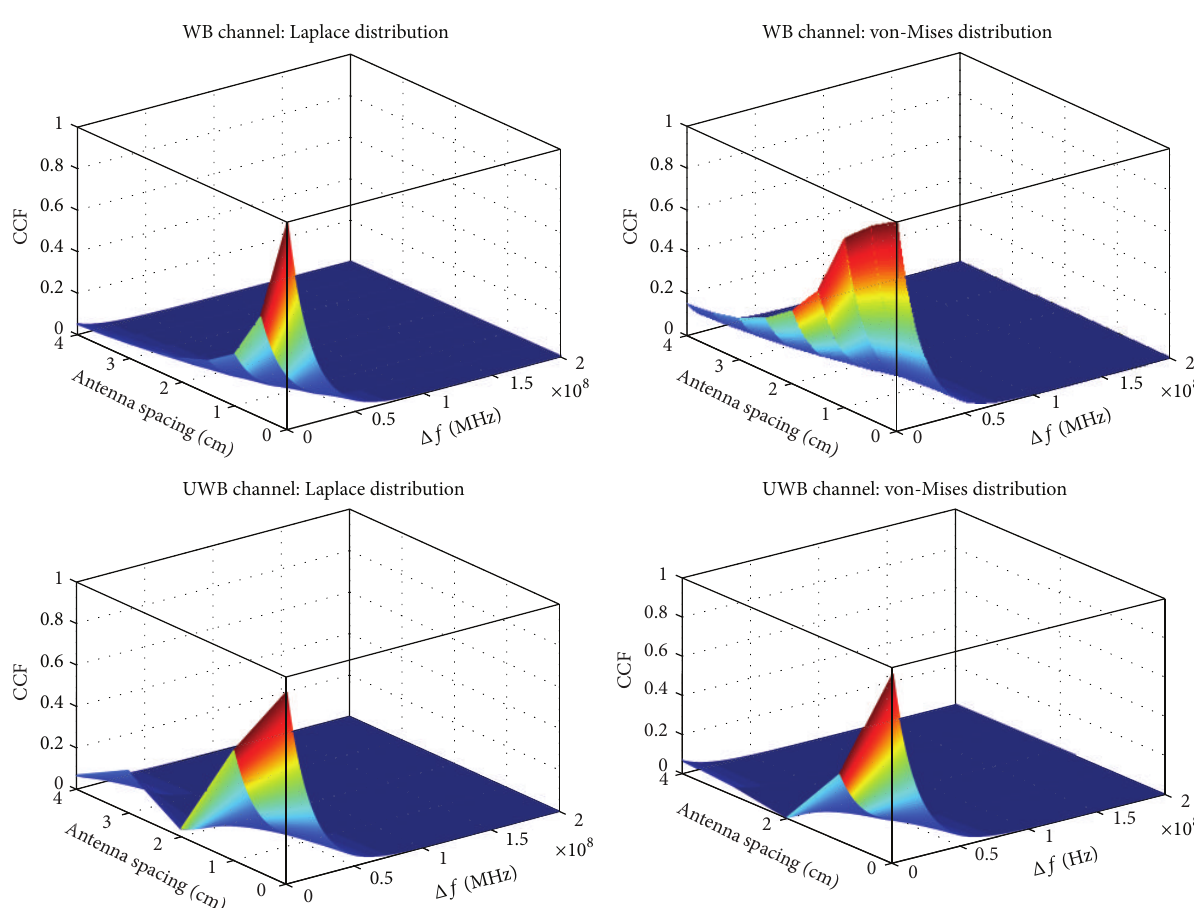
Figure 2: CCF corresponding to WB and UWB signals with omnidirectional APP, Laplace, and von-Mises PDFs of the propagation environment, with antenna spacing 𝜆/2 = 𝑐𝜋/𝜔 𝐻 and frequency offsets Δ𝑓 = 𝑓 2 − 𝑓 1